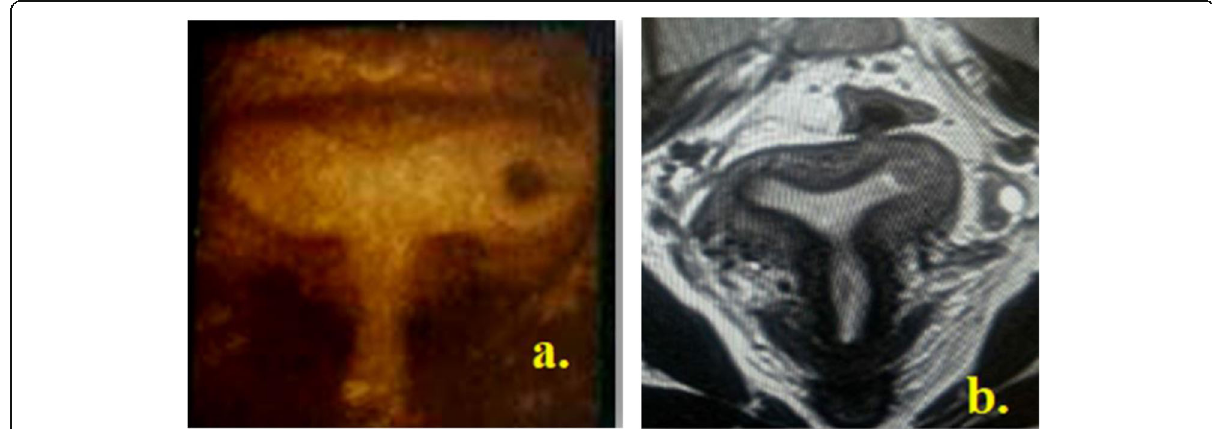
Fig. 4 A 28-year-old married female patient, complaining of abortion and 2-year infertility. Dysmorphic infantile uterus (class U1) by 3DTVS showed abnormal shape of the uterine cavity (not triangular) with uterine body to cervix ratio being 1:1, with mild internal indentation < 50% of uterine wall thickness (Fig. 1a). MR coronal T2 showing the same findings as 3DTVS (Fig. 1b)